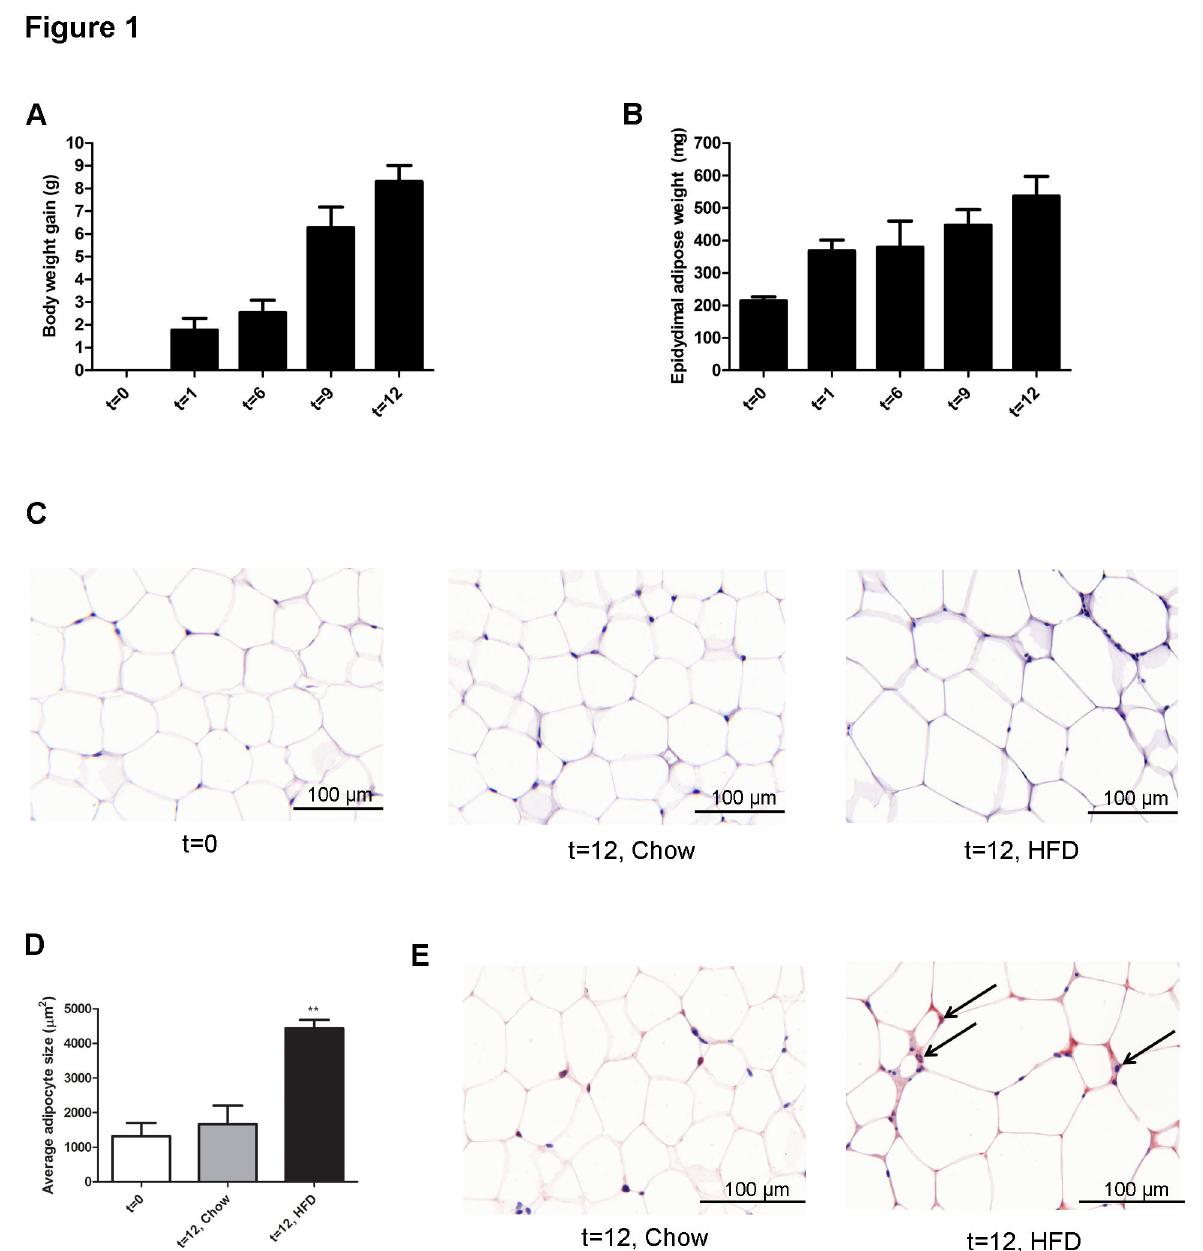
Figure 1. HFD feeding leads to obesity and onset of adipose tissue inflammation. APOE*3Leiden transgenic mice were fed a HFD for 12 weeks and sacrificed at the time points indicated. The average body weight at the start (t=0) of HFD feeding was 29.2 g. A , Body weight gain over time. B , Mass of the epididymal adipose tissue depot during obesity development. Data are presented as mean ± SEM. C , Histological analysis of adipose tissue at start (t=0) and after 12 weeks of HFD or chow feeding (reference for the effect of aging). D , HFD feeding results in adipocyte hypertrophy. Computer-assisted quantification of average adipocytes size (P<0.05). E , Marked accumulation of CCR2 positive cells (arrows) in the HFD fed group.